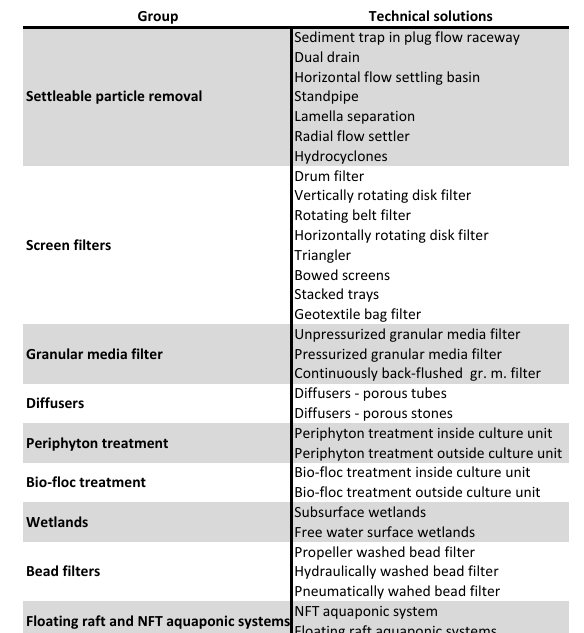
Table 1. Grouping of Technical solutions with a similar effect for easier reading of the matrix presented in Tables 2 to